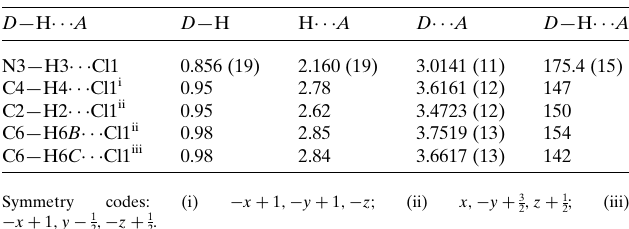
Table 1 Hydrogen-bond geometry (A˚ , (cid:5) ).